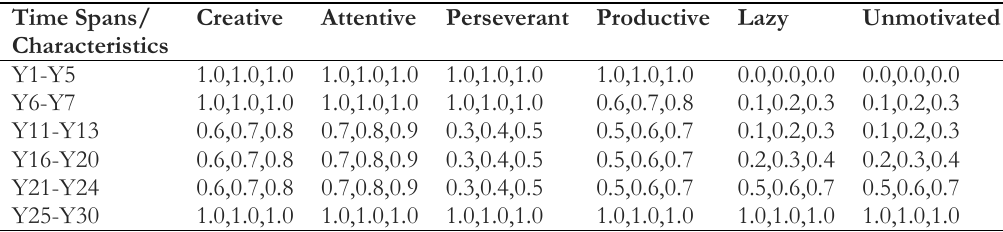
Table 2. The change in the values of fuzzy membership degrees for candidate 1 during 30 years in several time spans.